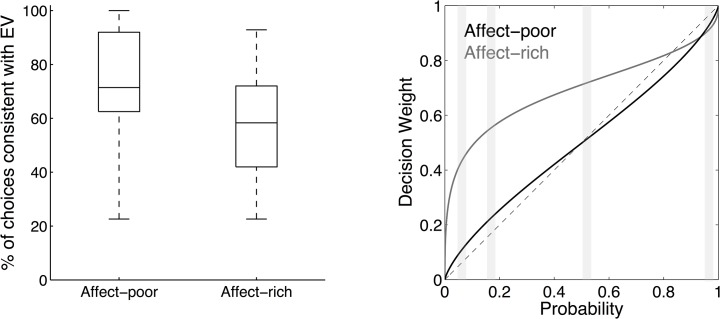
Expected Value Choices and Weighting Functions.(A) Median percentage of choices of the option with the higher expected value, separately for the affect-rich and the affect-poor problems. In each box, the central mark is the median, the edges of the box are the 25th and 75th percentiles, and the whiskers extend to the most extreme data points. (B) Cumulative prospect theory’s weighting function fitted to the choices in the affect-poor and affect-rich problems (here, using the average parameter values across all participants; Table 1). Probability levels used in the experiment are shaded. The dotted line indicates identity of probabilities and decision weights.